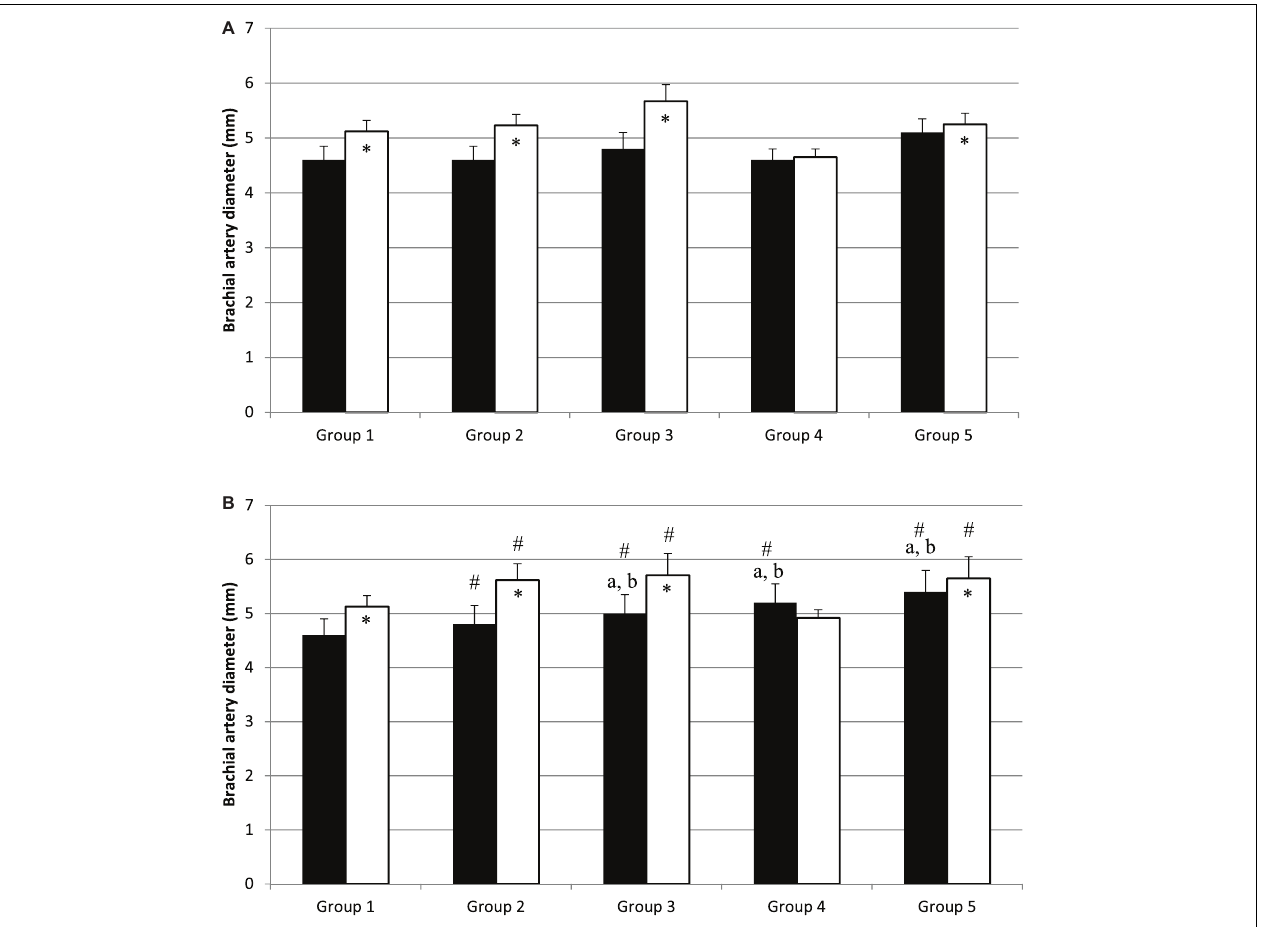
FIGURE 1 | Diameter of brachial artery before (black bars) and after (white bars) occlusion, before (A) and after (B) physical work capacity (PWC 170 ). ∗ Significantly different from basal diameter ( p < 0.05). #Significantly different from before exercise ( p < 0.05). a , b Significantly different ( p < 0.05) from Group 1 and Group 2,